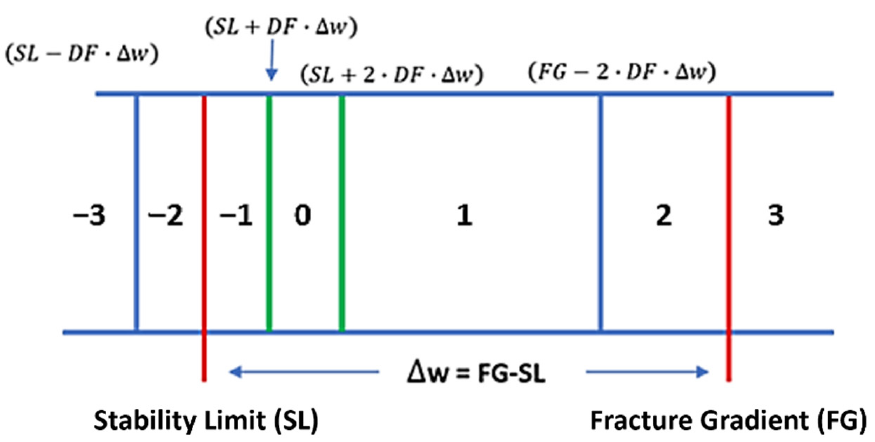
Figure 7. Functional value assignment for the ECD parameter.